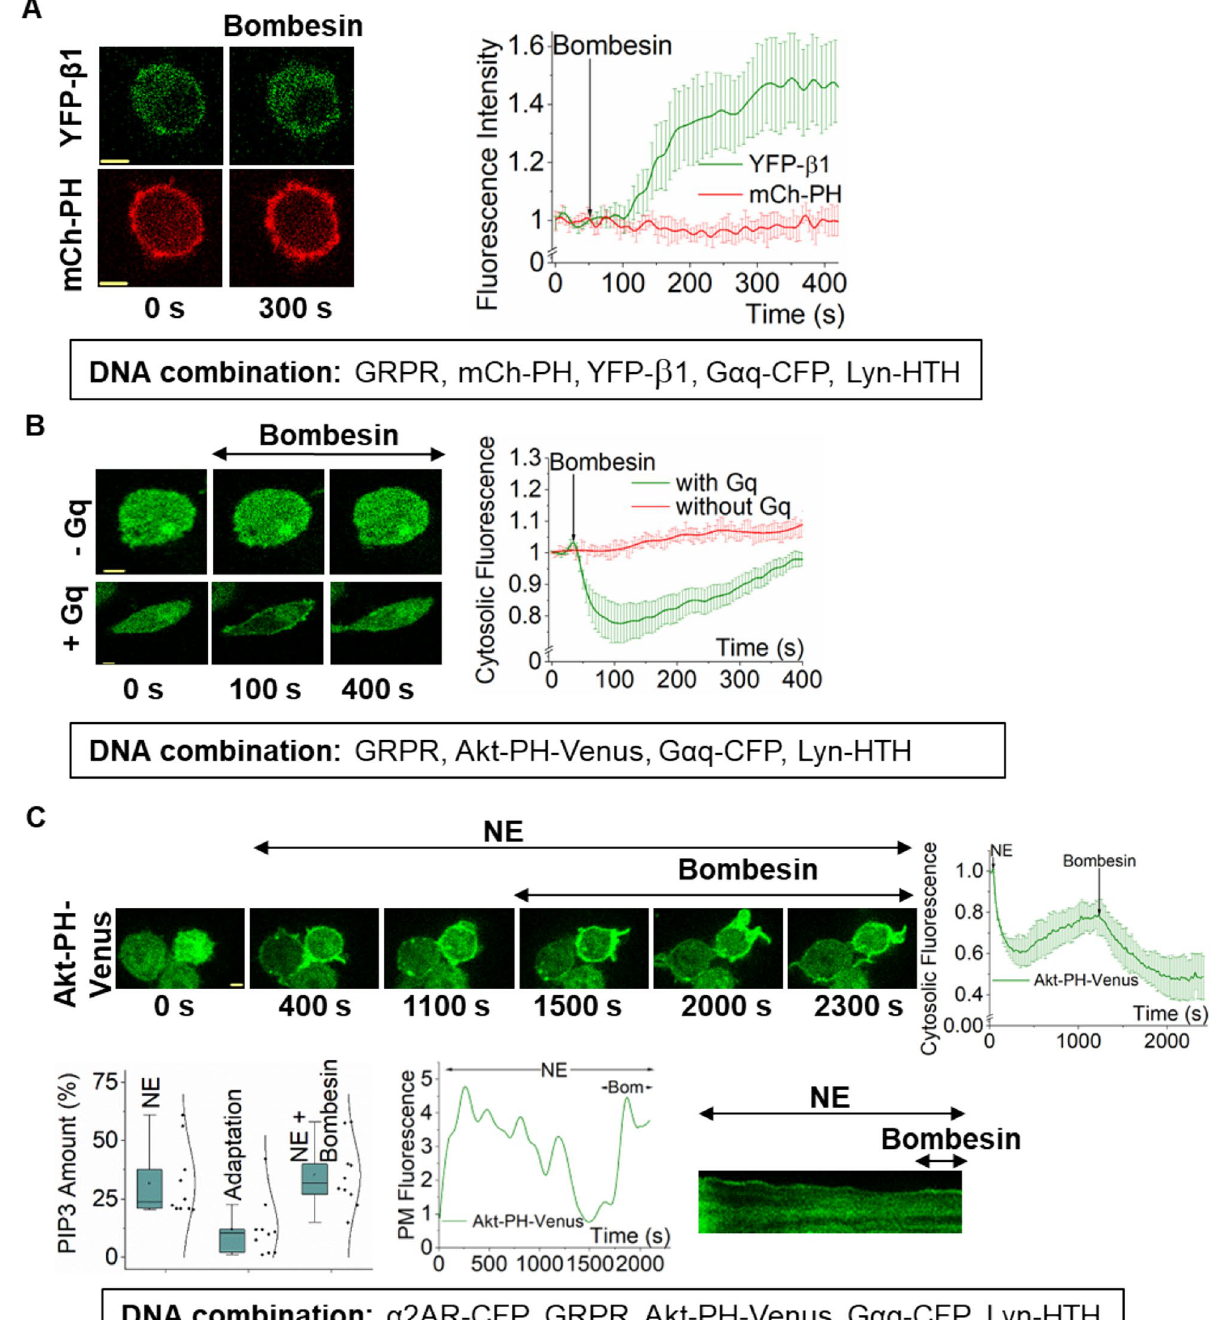
Figure 4. Despite the source, Gβγ entry induces PIP3 generation and loss results in attenuation. ( A ) RAW264.7 cells expressing GRPR, YFP-β1, mCh-PH, Gαq-CFP, and Lyn-HTH exhibited robust β1 translocation upon GRPR activation with bombesin (1 µM at 1 min) (n = 8). However, GRPR activation did not induce PIP2 hydrolysis due to the presence of Lyn-HTH. The plot shows the dynamics of β1 translocation (green) and PIP2 (red) in cells. ( B ) RAW264.7 cells expressing GRPR, Akt-PH-Venus, Gαq-CFP, and Lyn-HTH exhibited PIP3 production and attenuation upon GRPR activation with 1 µM bombesin (n = 8). However, control cells expressing only GRPR and Akt-PH-Venus did not show PIP3 production upon GRPR activation (n = 9). The plot shows PIP3 production and attenuation only in Gαq-expressing cells (green), however not in control cell lacking introduced Gαq. ( C ) RAW264.7 cells expressing α2AR-CFP, GRPR, Akt-PH-Venus, Gαq-CFP and Lyn-HTH exhibited PIP3 production and attenuation upon α2AR activation. After PIP3 attenuation, 1 µM bombesin was added (at 20 min) to activate GRPR. GRPR activation in these Gαq cells caused disruption of attenuation in the form of PIP3 increase. The plot shows the initial PIP3 generation and attenuation after α2AR activation, and subsequent GRPR-induced PIP3 regeneration in Gαq background (n = 10). Kymographs show PIP3 levels on the plasma membrane. Average curves were plotted using cells from ≥ 3 independent experiments. ‘n’ denotes the number of cells’ data used to plot the average curve. The error bars represent SEM (standard error of mean). The scale bar = 5